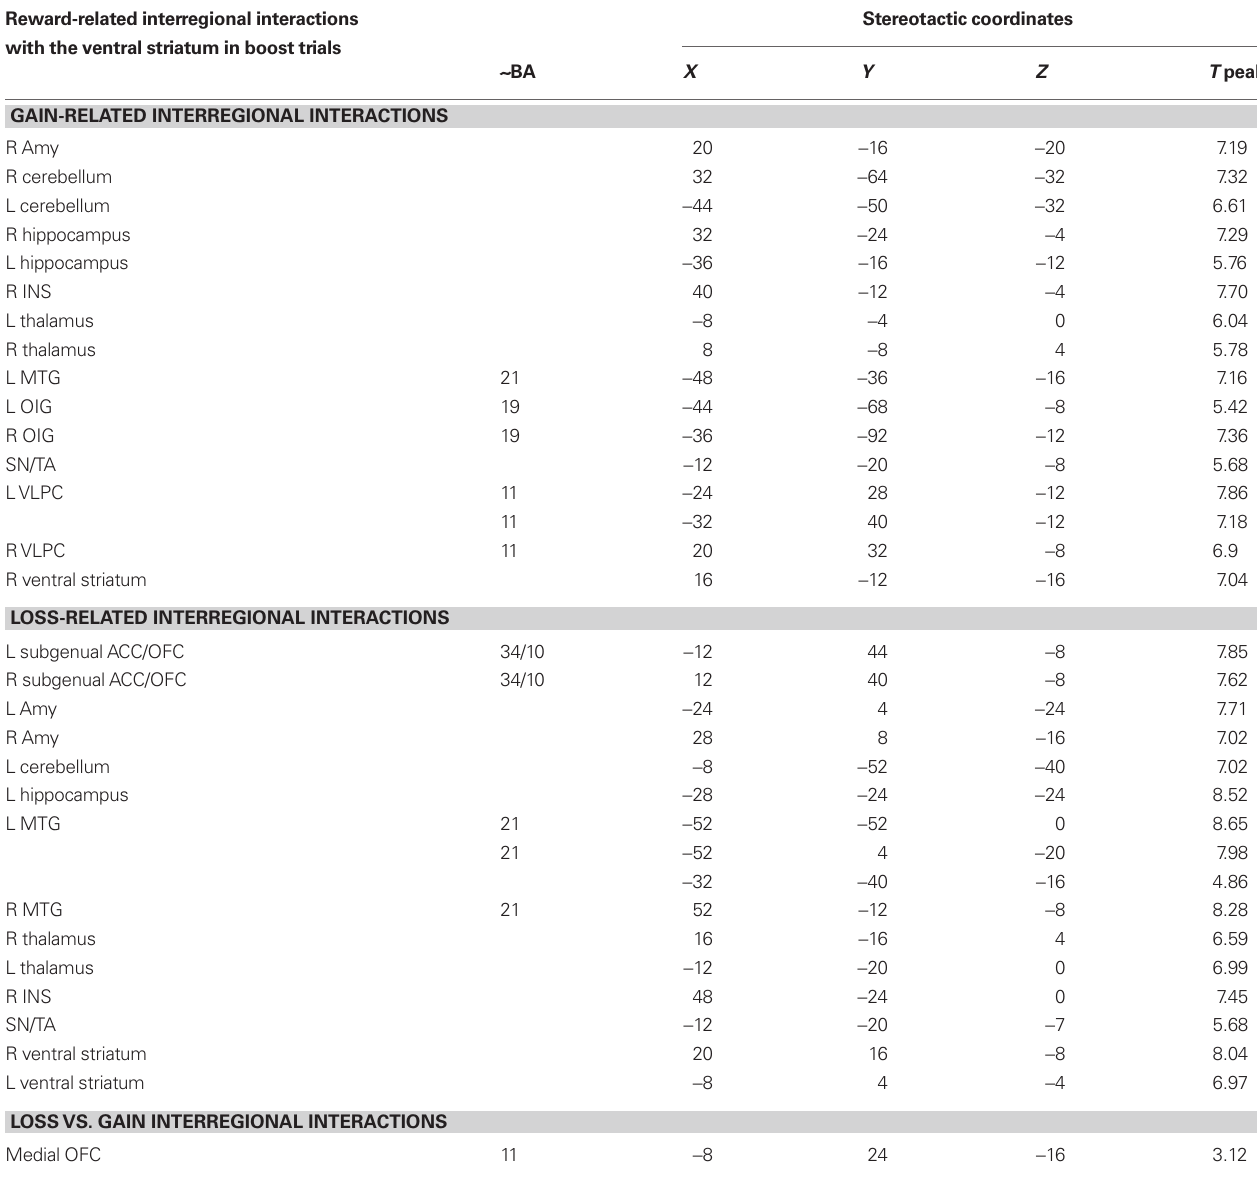
Table 3 | Main effects for valence in the interregional interactions with the ventral striatum for boost trials. Reward-related interregional interactions Stereotactic coordinates